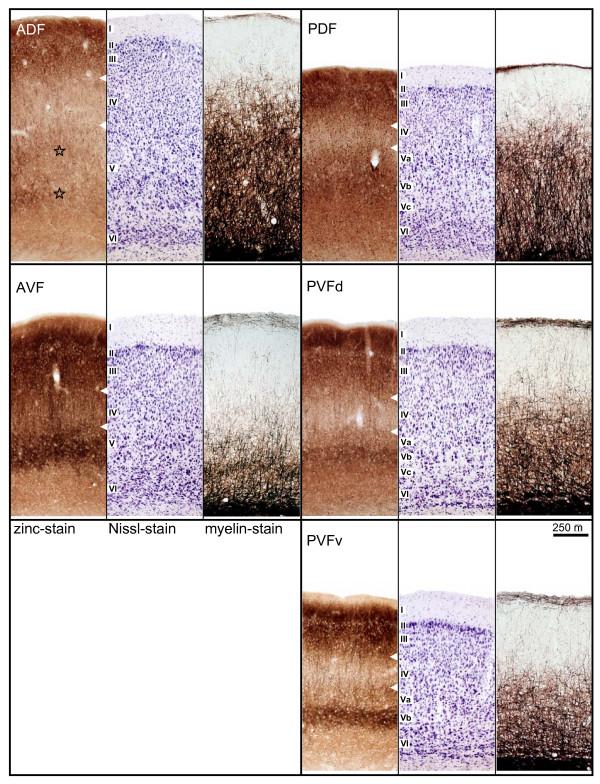
Cut-outs of frontal sections from the centers of the different cortical fields. Field names are given in the zinc-stained section and apply to the two neighboring photographs to the right. Indications of layers in the Nissl-stained sections apply to the neighboring left (zinc-stained) and right (myelin-stained) sections, respectively. White arrowheads in the zinc-stained sections indicate the borders of layer IV. Stars in the cut-out of the zinc-stained section of ADF highlight the two components of layer V. The scale bar of 250 μm applies to all cutouts. Abbreviations as in Fig. 1C.